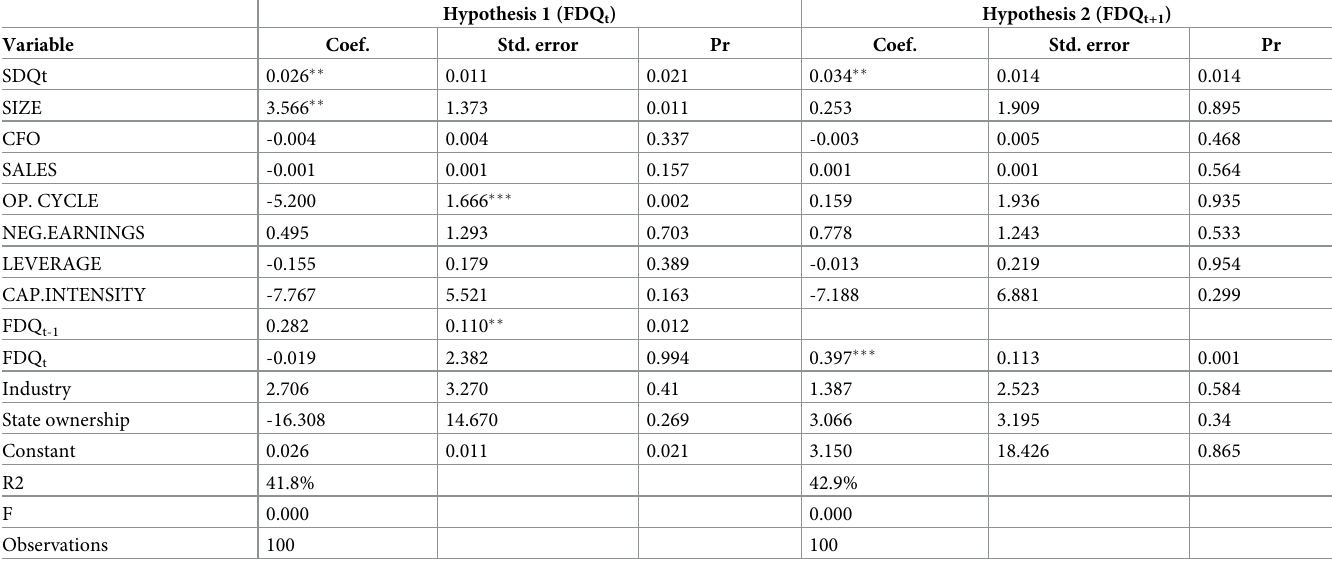
Table 8. Relationship between financial disclosure quality and sustainability disclosure quality (with industry membership and state